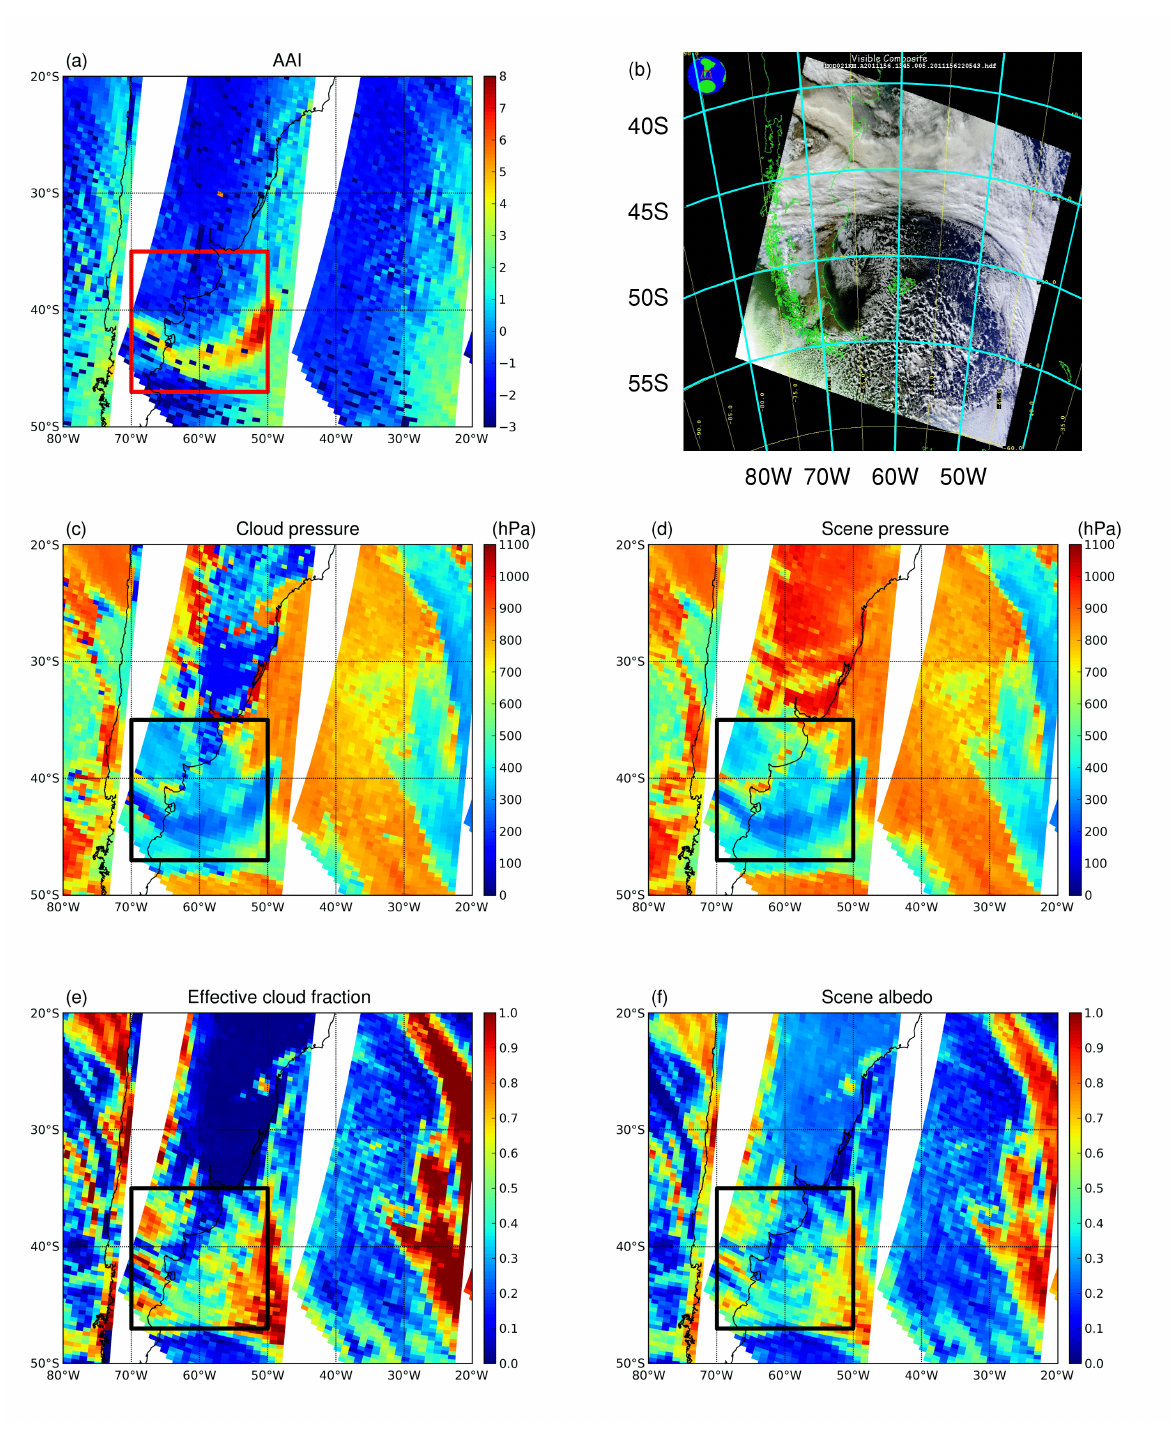
Fig. 9. (a) GOME-2 AAI image, (b) MODIS RGB image, (c) GOME-2 cloud pressure, (d) GOME-2 scene pressure, (e) GOME-2 effective cloud fraction, and (f) GOME-2 scene albedo for the Puyehue volcanic ash plume on 5 June 2011. The location of the plume is indicated with a box in the GOME-2 images. The plume in the box was measured around 12:50UTC. MODIS image was measured at 13:45 UTC and was downloaded from LAADS Web (http://ladsweb.nascom.nasa.gov/browse images/).